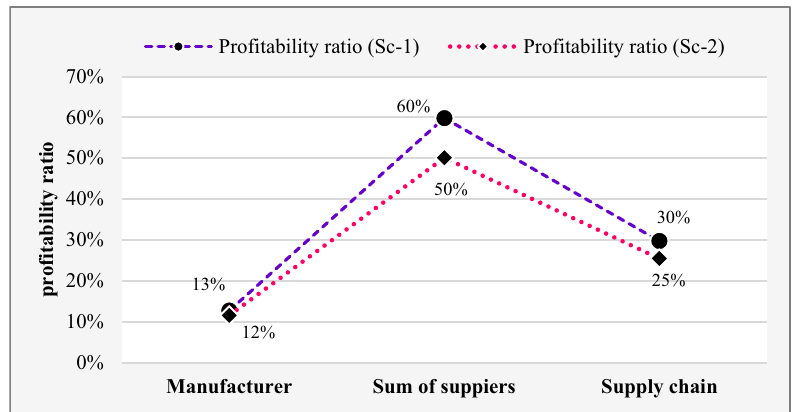
Fig. 12 A comparison of the profitability ratios for SC, suppliers, and the manufacturer in Sc-1 and Sc-2 for problem size 1